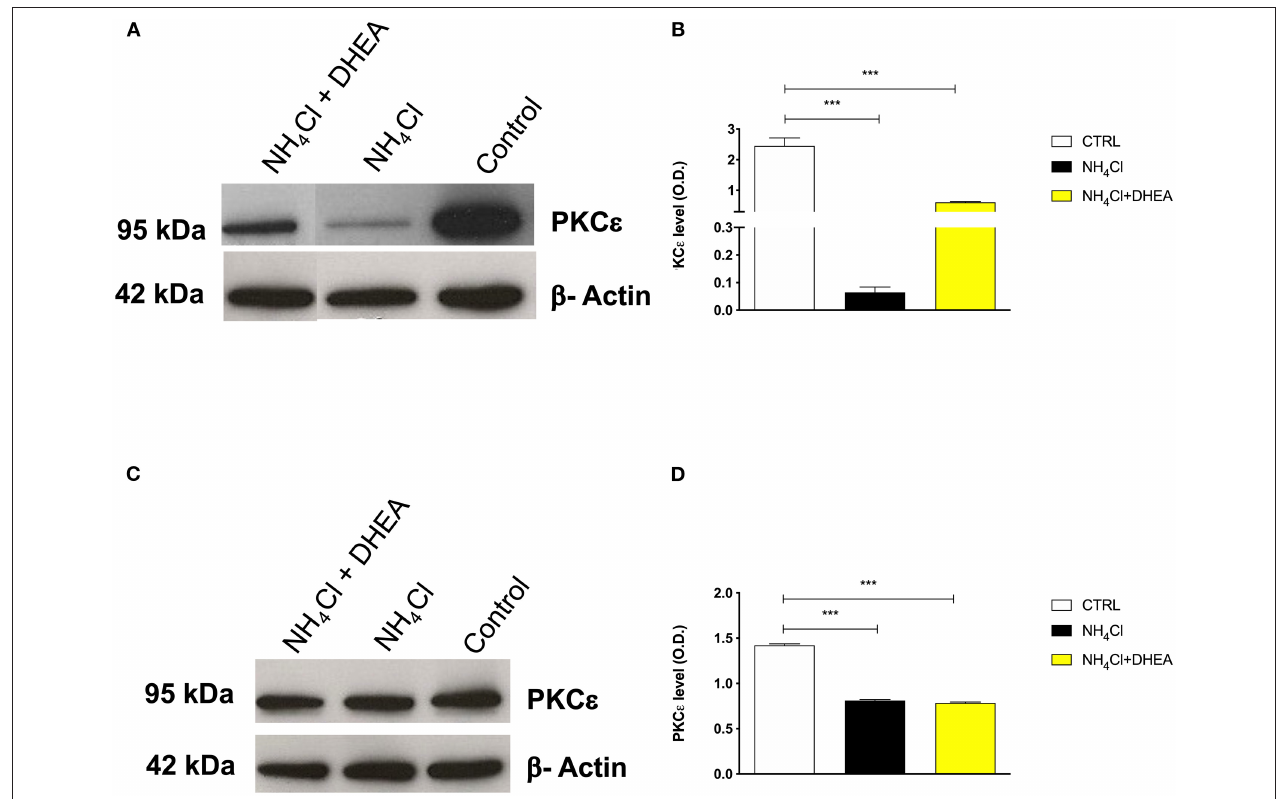
FIGURE 4 | Western blot analysis of cortex (A) and cerebellum (C) PKC ε expression after 48h of treatment with saline (control), NH 4 Cl, and NH 4 Cl + DHEA ( β -actin was used as internal standard) and their respective representative blots (B,D) ; *** p < 0.001. Western blot pictures were spliced since cortex and cerebellum samples were loaded in wells far from the